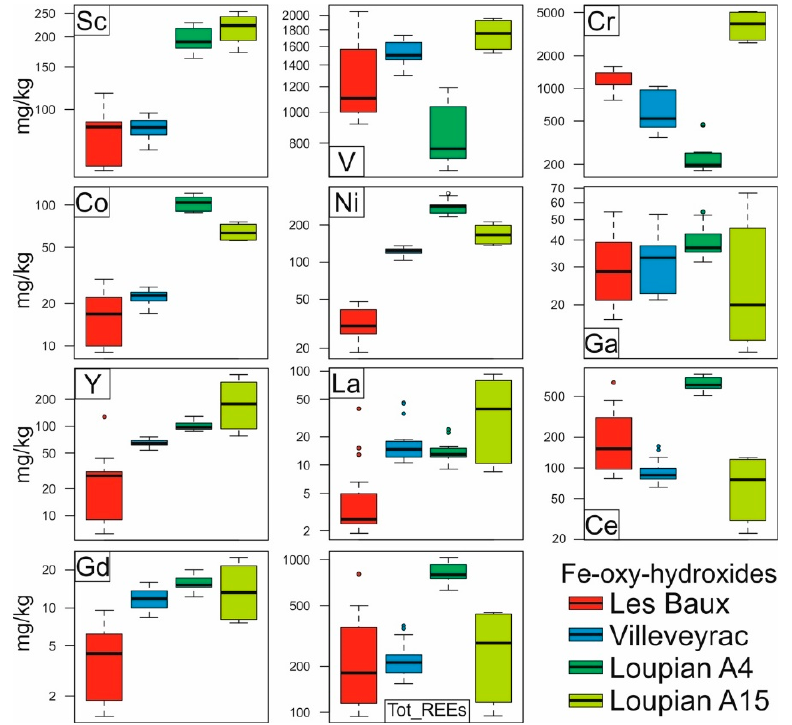
Figure Figure 5. Boxplots reporting the compositions (mg/kg) of selected elements in the analyzed Fe ‐ oxy ‐ hydroxides. Individual LA ‐ ICP ‐ MS analyses are given in Table S3.